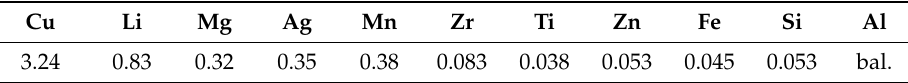
Table 1. The composition (in wt.%) of the 2050